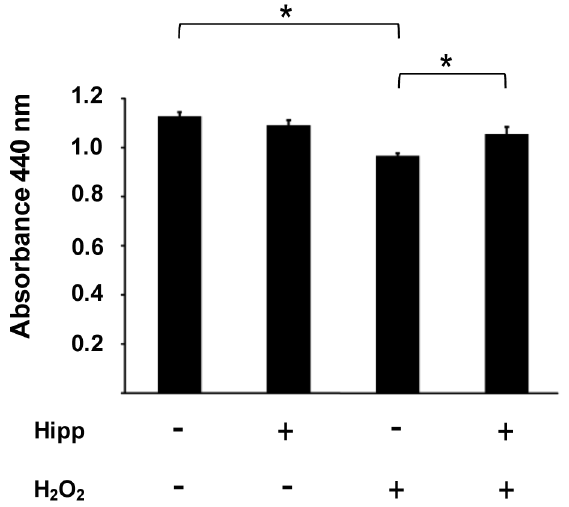
Figure 5. Hippuristanol treatment protects cells from oxidative stress. SH-SY5Y cells were pre-treated with hippuristanol or DMSO control for 4 hours, followed by 50 m M H 2 O 2 or control treatment for two hours. After a 22 hour recovery period, viability was determined by WST assay. Significant differences (p # 0.05 by t-test) are indicated by asterisks.